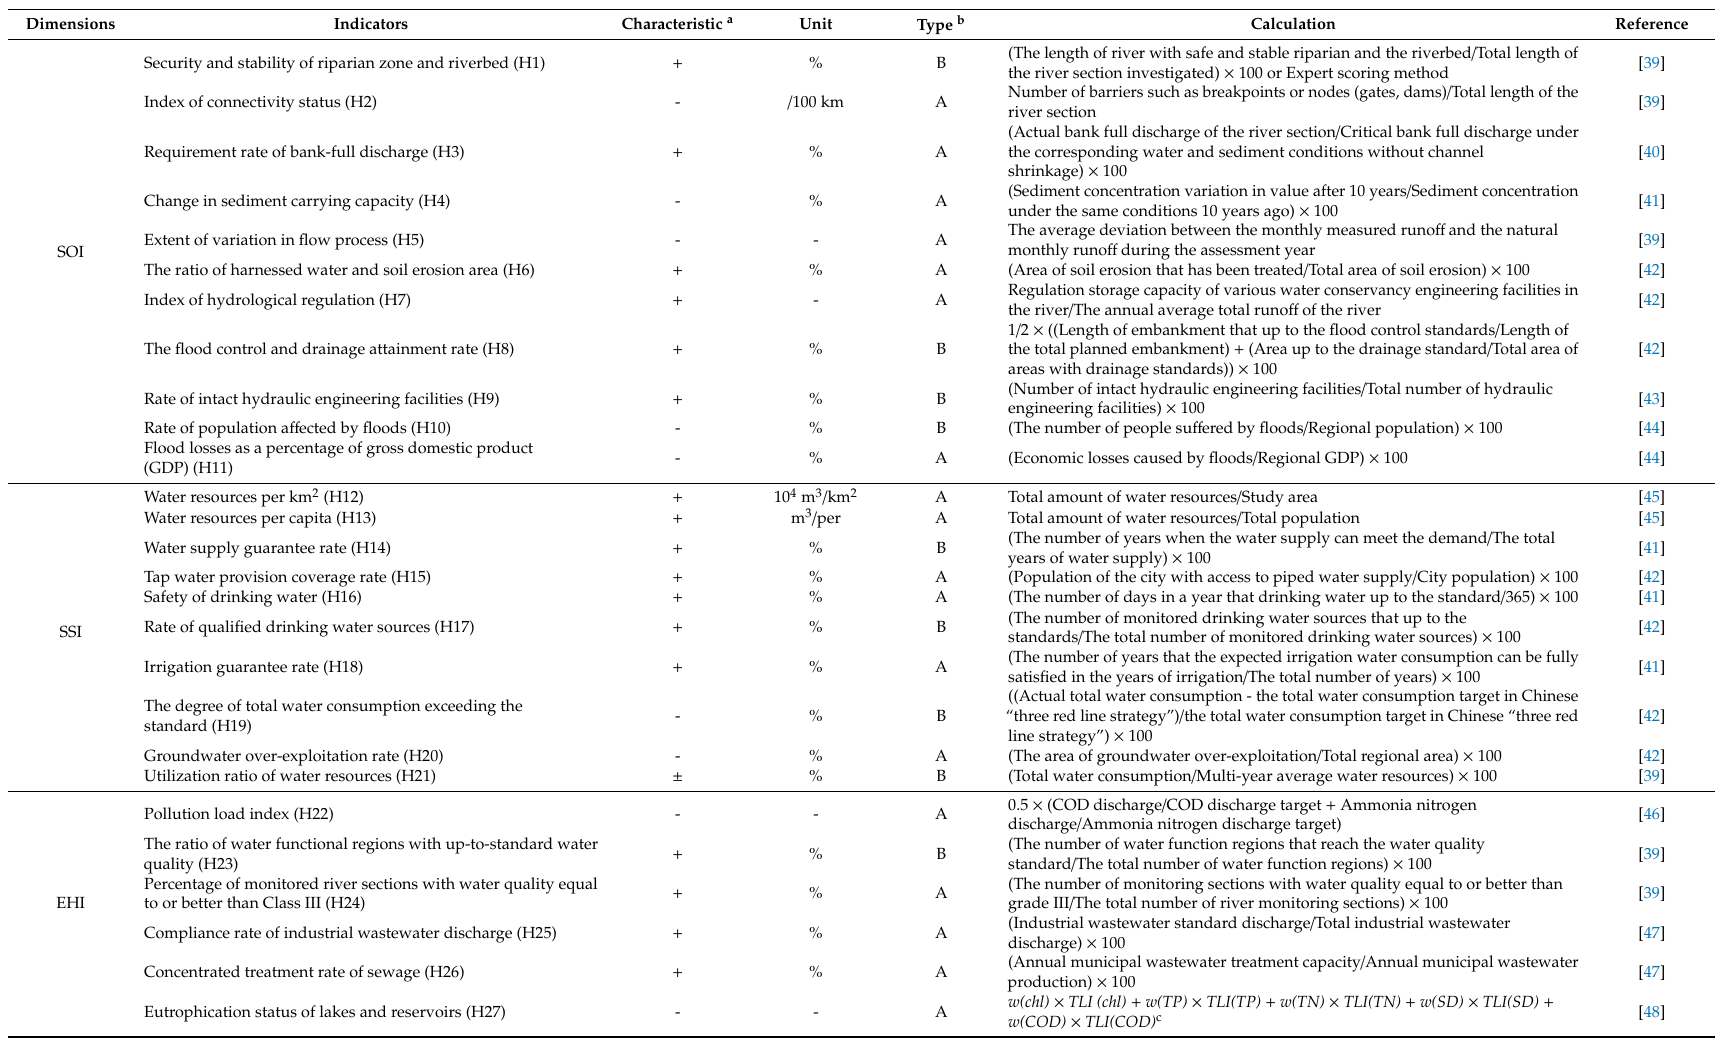
Table 1. Indicators selected within a Happy River Index (HRI) evaluation